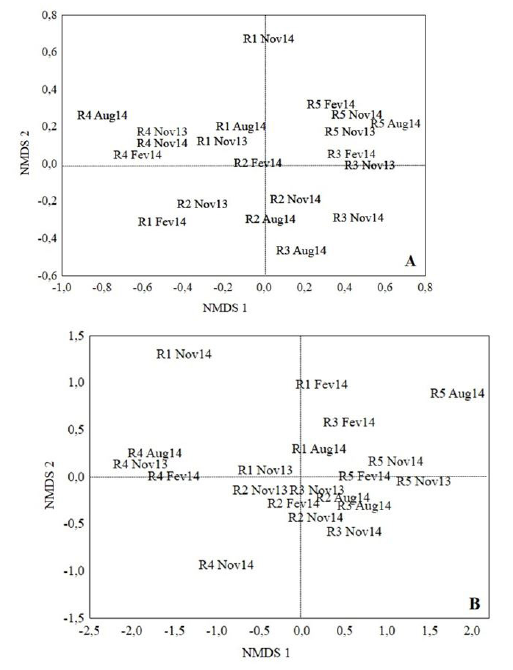
Figure 6. Non-Metric Multidimensional Scaling (NMDS) for the distribution of phytoplankton richness (a) and biomass (b) in the